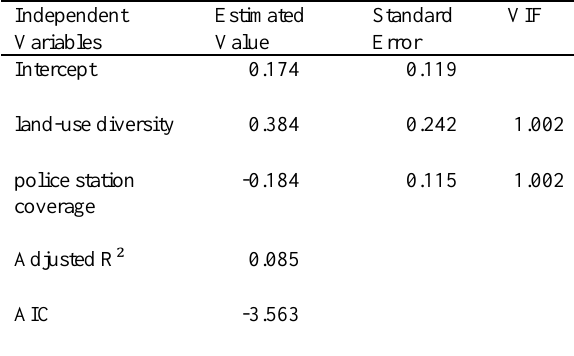
Table 2. Ordinary Least Squares (OLS) results